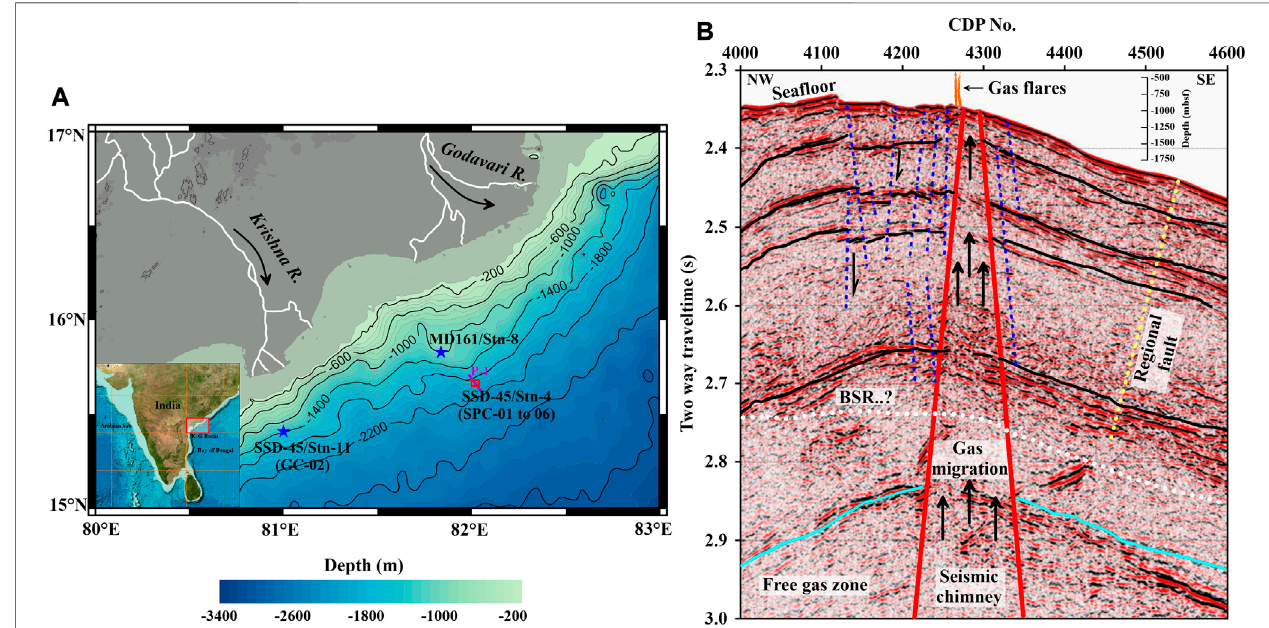
FIGURE 1 | (A) Map showing the location of active (SSD-45/Stn-4), relict (SSD-45/Stn-11/GC-02) and paleo (MD161/Stn-08) seep sites in the Krishna-Godavari (K-G) basin, Bay of Bengal High resolution seismic pro fi le (P1) highlighting (B) the normal faults (blue dashed lines), subsurface chimney like feature (solid red lines) and water column imaging showing gas fl ares (orange). Regional toe-thrust fault (yellow dashed line), feasible BSR (white dashed line), and subsurface horizons (solid black lines) are marked on the seismic section (modi fi ed after Dewangan et al., 2020). The spade sediment cores SPC-01, SPC-02, SPC-03, SPC-04, SPC-05,